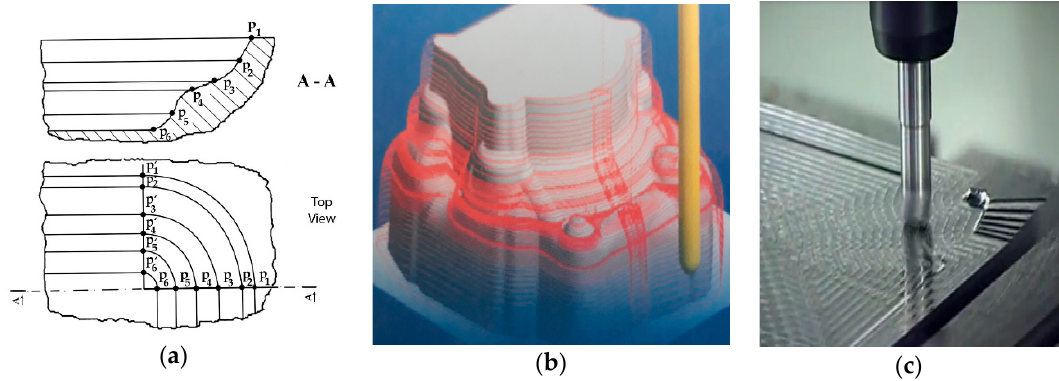
Figure 1. The concept of complex surface processing in space in 2 ½ D with the geometric shape deviations. ( a ) Section and top view of the complex surface in space pocket type; ( b ) The concept of complex surface processing in 2 ½ D; ( c ) The geometric shape deviations of the part.